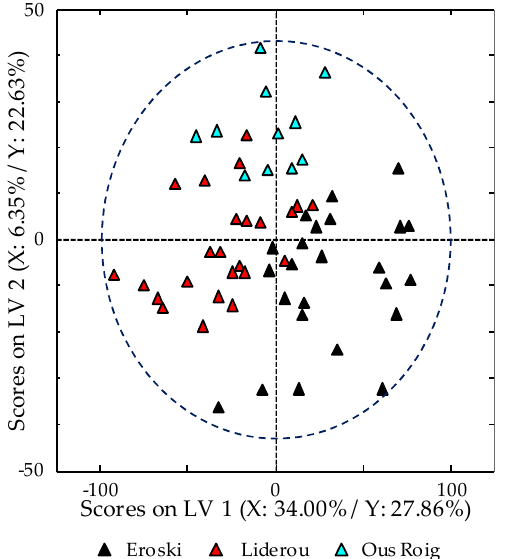
Figure 5. PLS-DA scores plots of LV1 vs. LV2 for B hen egg when using HPLC-UV chromatographic fingerprints registered at 250 nm as chemical descriptors.